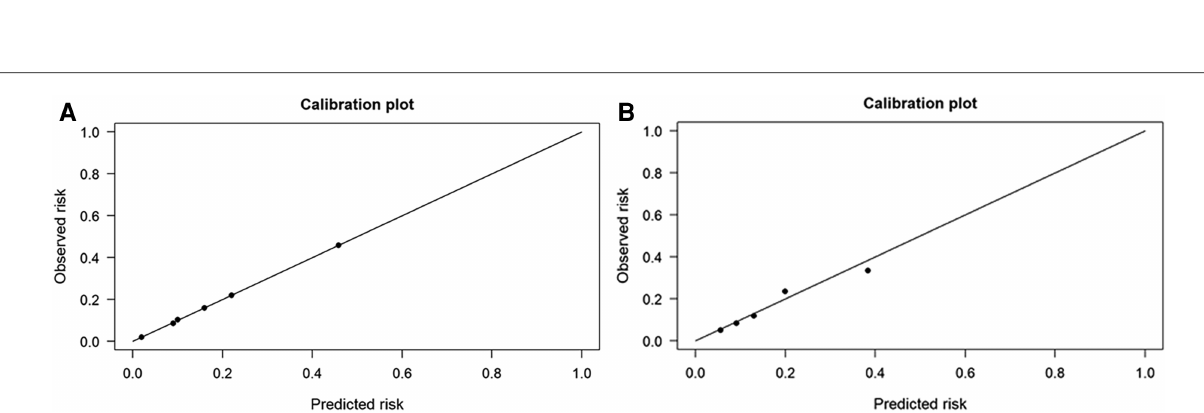
FIGURE 3 Reciver-Operationg Characteristic (ROC) curves of Bayesian network (BN) model and logistic regression model for predicting ischemic stroke (IS) in patients with cardiac myxoma (CM). ( A ) Logistic regression model. ( B ) Bayesian network model.